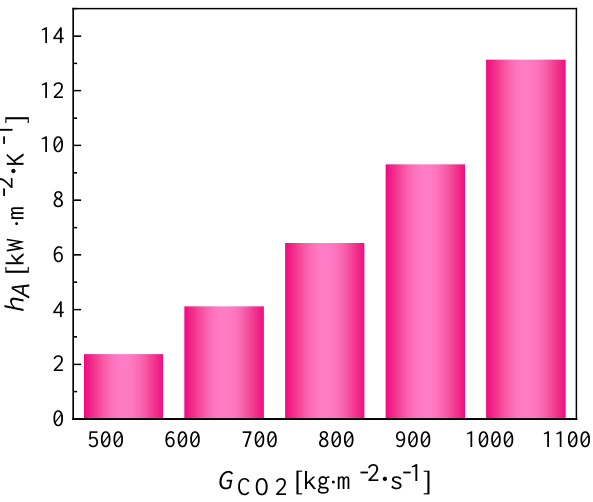
Figure 14. Variation in the average heat transfer coefficient of CO 2 at different mass fluxes.